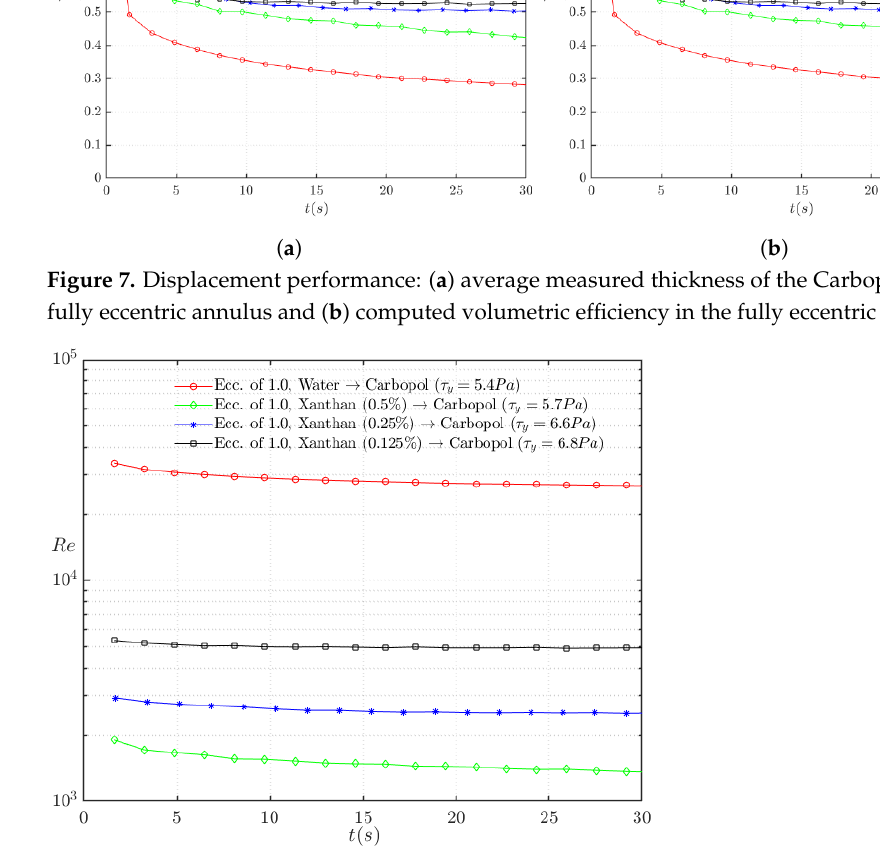
Figure 8. Computed Reynolds number for the displacing fluid in the fully eccentric